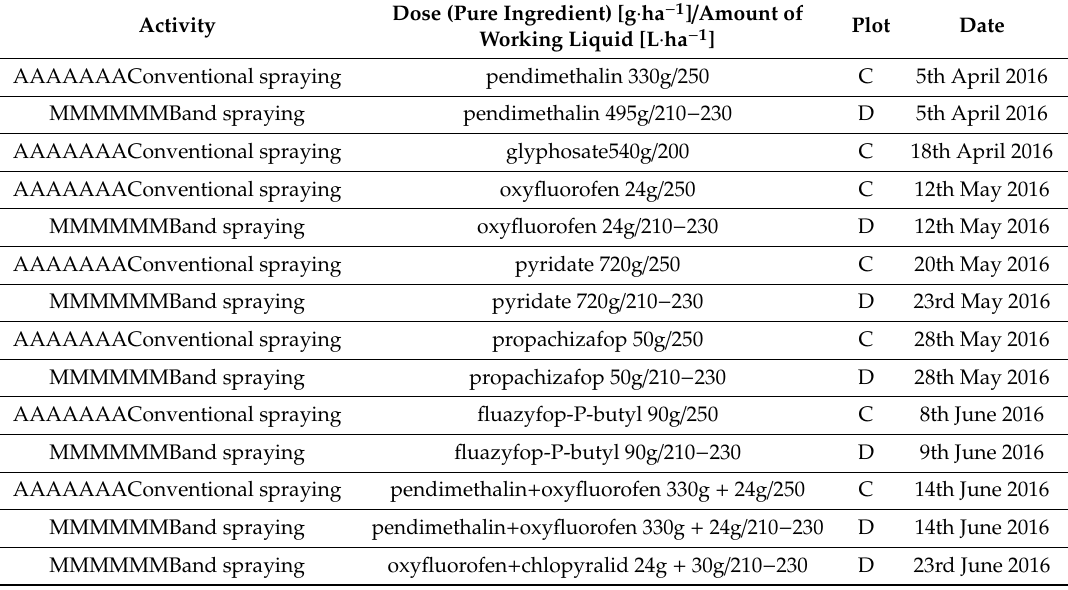
Table 1. Table of the used herbicides.